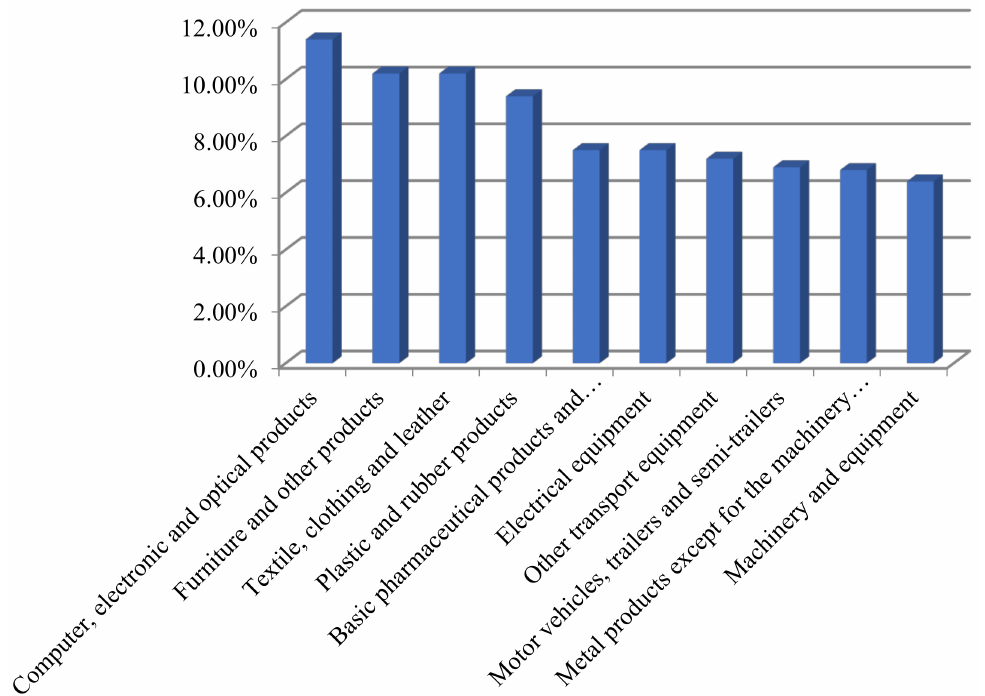
Figure 4. Top 10 consumer goods products according to the estimated price increase (%). Source: compiled by the author according to